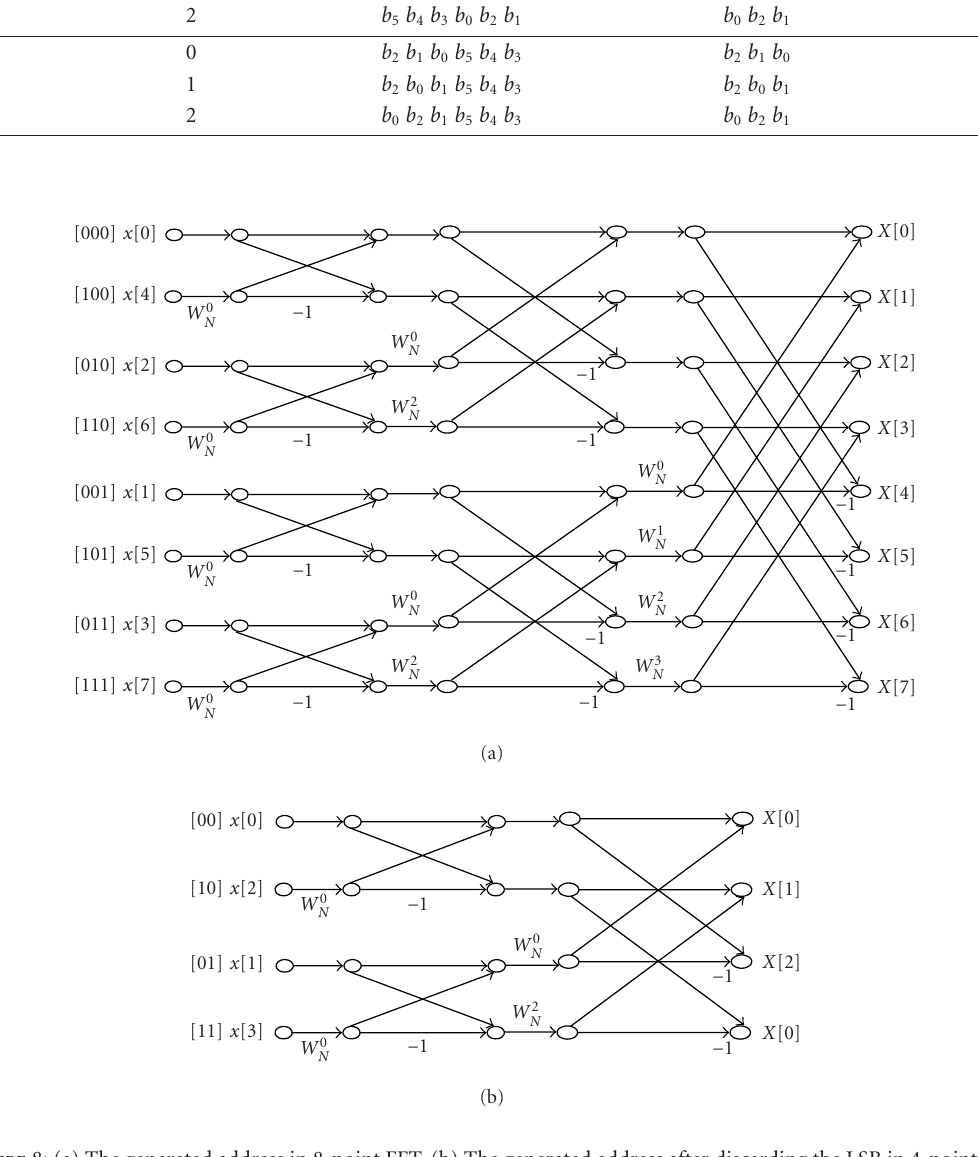
Figure 8: (a) The generated address in 8-point FFT. (b) The generated address after discarding the LSB in 4-point